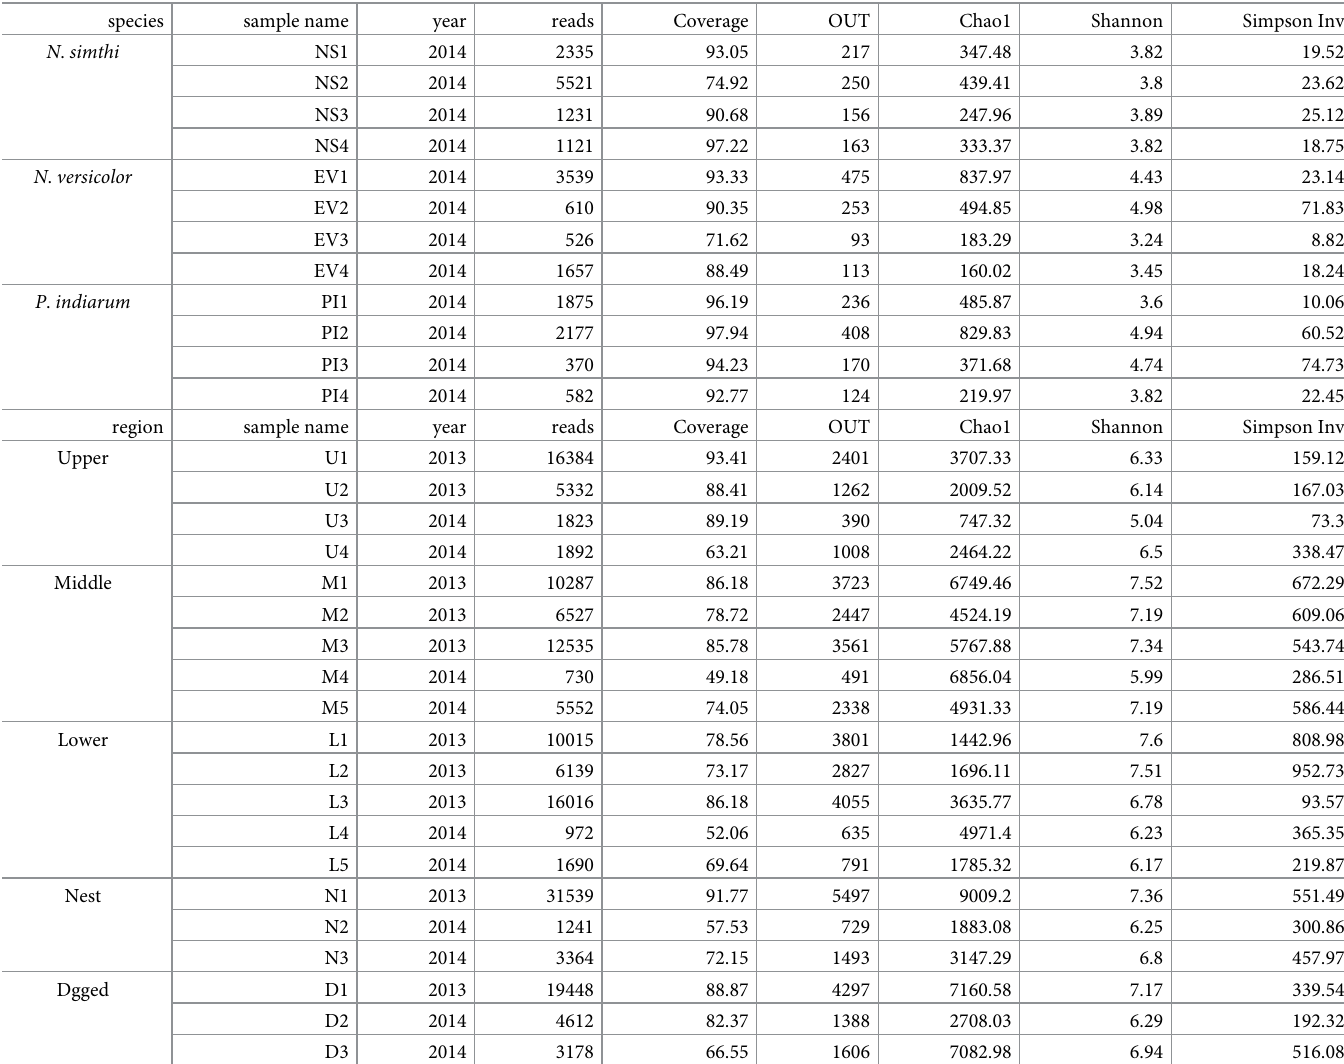
Table 1. Parameters for metagenome analysis.